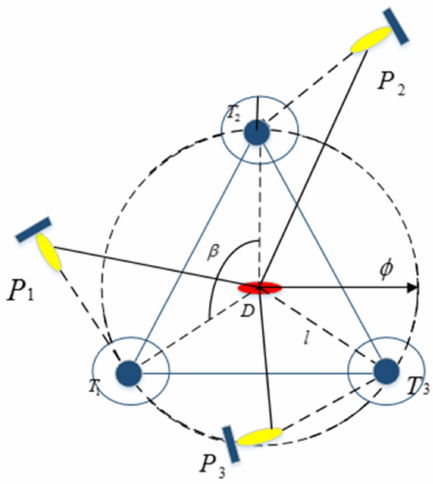
Figure 10. Distribution of potential points in the process of